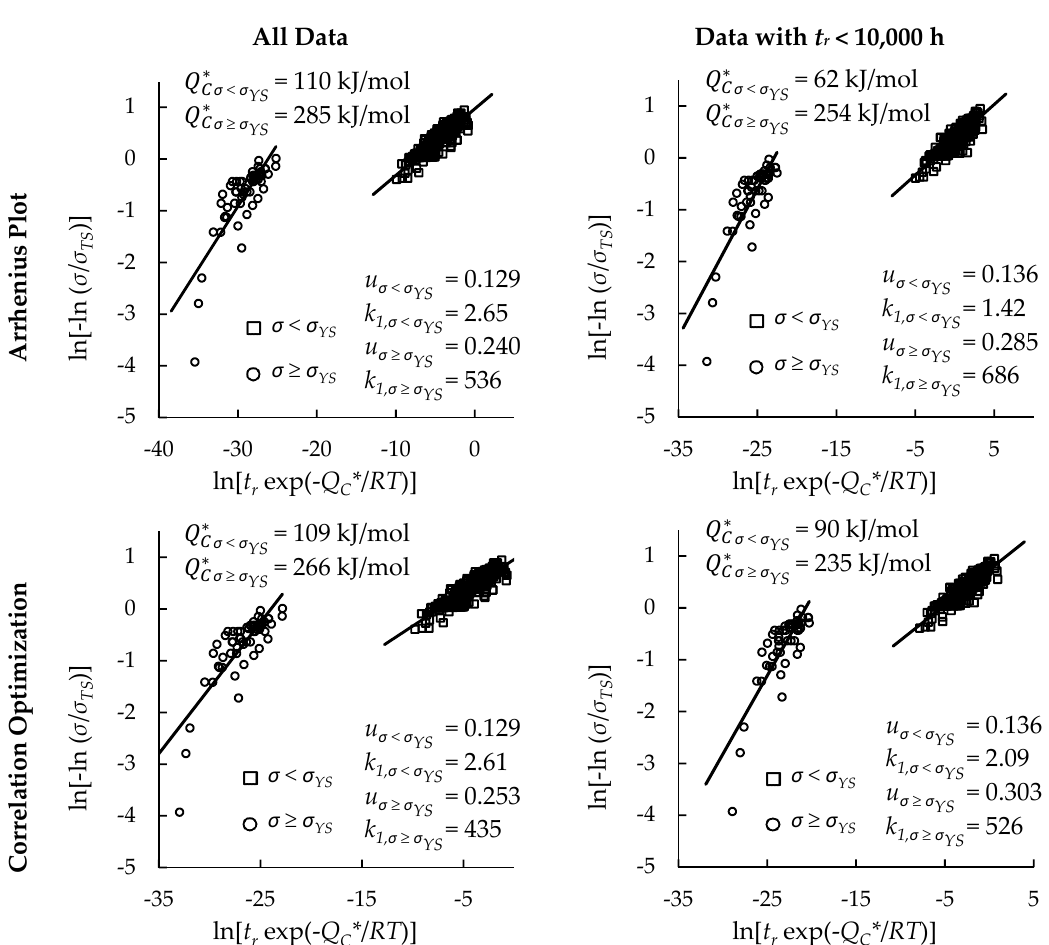
Figure A3. Wilshire plots of Inconel 617 creep rupture data split into above- and below-yield stress regions.